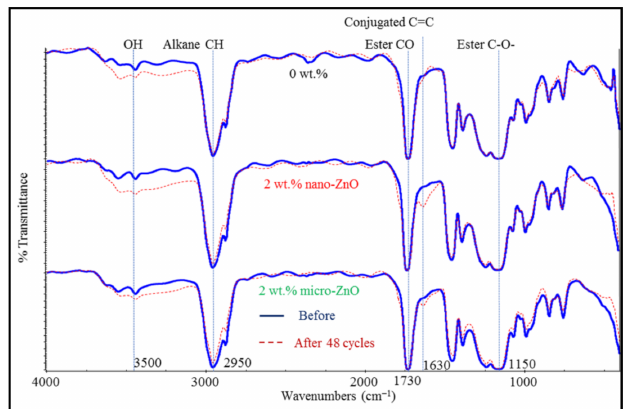
Figure 4. IR spectra of the coatings without ZnO particles (0 wt.%), with 2 wt.% nano-ZnO and 2 wt.% micro-ZnO before and after 48 cycles of UV/CON